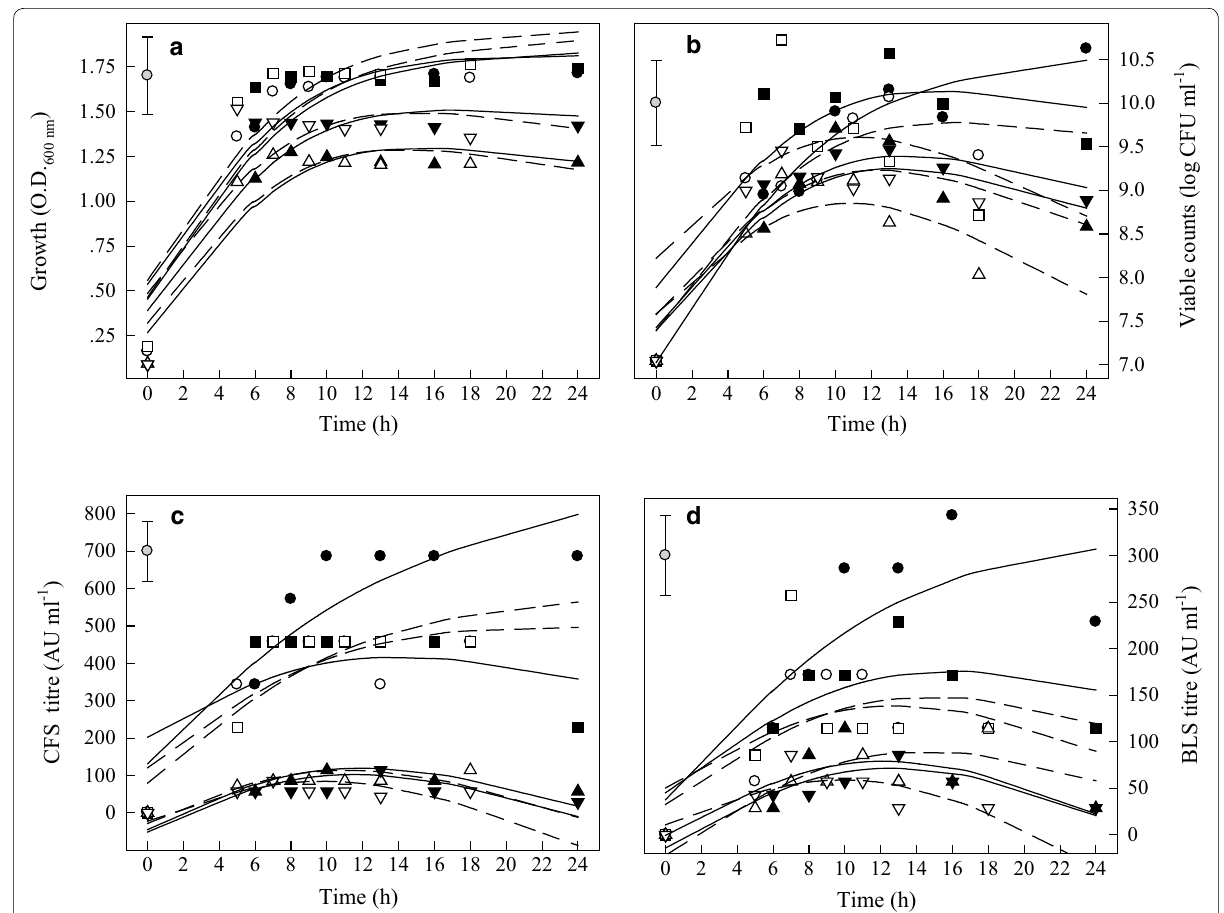
Fig. 5 OD values, viability, and antimicrobial activities (AU) of CFS and BLS of TSB-8 strain under different growth conditions. ( ● ) MRS, pH 6.2, 37 °C; ( ○ ) MRS, pH 6.2, 44 °C; ( ■ ) MRS, pH 7.4, 37 °C; ( □ ) MRS, pH 7.4, 44 °C; ( ▲ ) BHI, pH 5.5, 37 °C; ( △ ) BHI, pH 5.5, 44 °C; ( ▼ ) BHI, pH 6.2, 37 °C; ( ▽ ) BHI, pH 6.2, 44 °C. a Optical density (OD); b LAB viable counts; c antimicrobial activity of CFS and d antimicrobial activity of BLS. The experimental data were fitted to the logistic model. The vertical bar represents standard errors of the